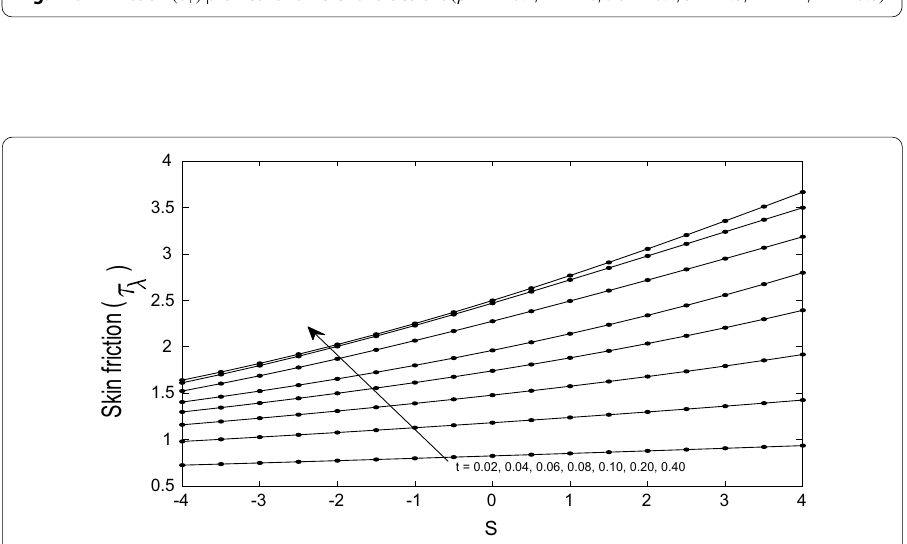
Fig. 7 Skin friction (τ 1 ) profiles for different values of t (β